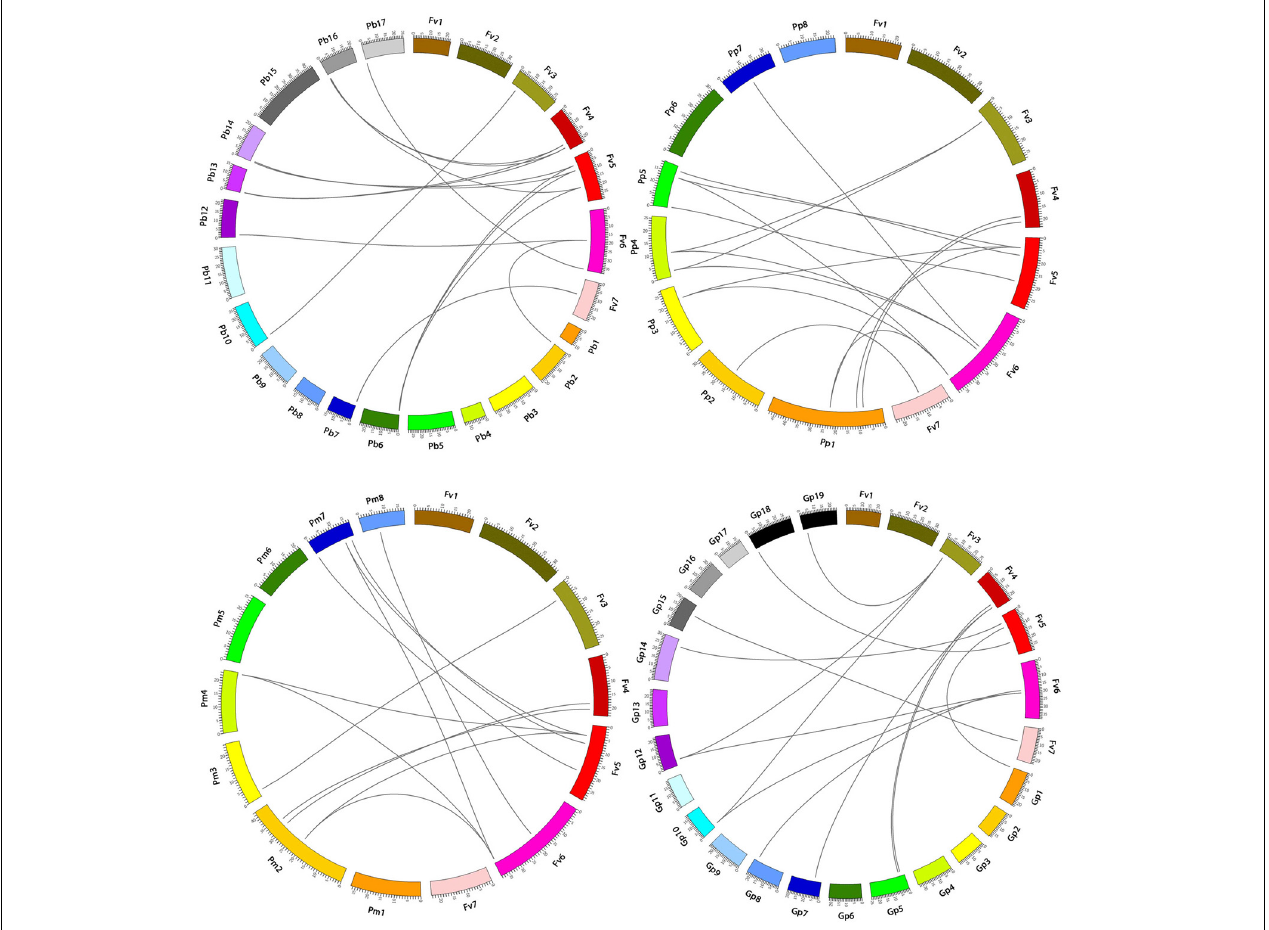
FIGURE 7 | Microsynteny of regions among Strawberry, Pear, Mei, Peach, and Grape. The chromosomes number indicated by different colored boxes and labeled by Fv, Pb, Pm, Pp, and Gp. The different color box also represents the sequence lengths of chromosomes in megabases. The black line indicates the syntenic relationship among the SBP-box